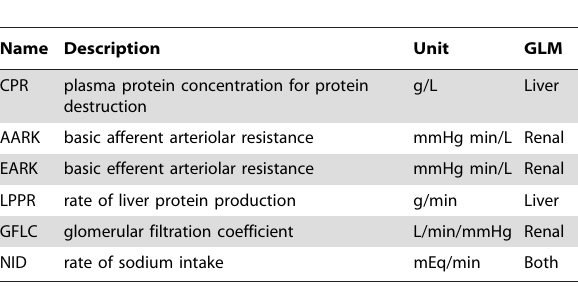
Table 6. The parameters used to predict hypertension in the reduced-parameter GLMs (‘‘Renal’’, ‘‘Liver’’ and ‘‘Renal + Liver’’).